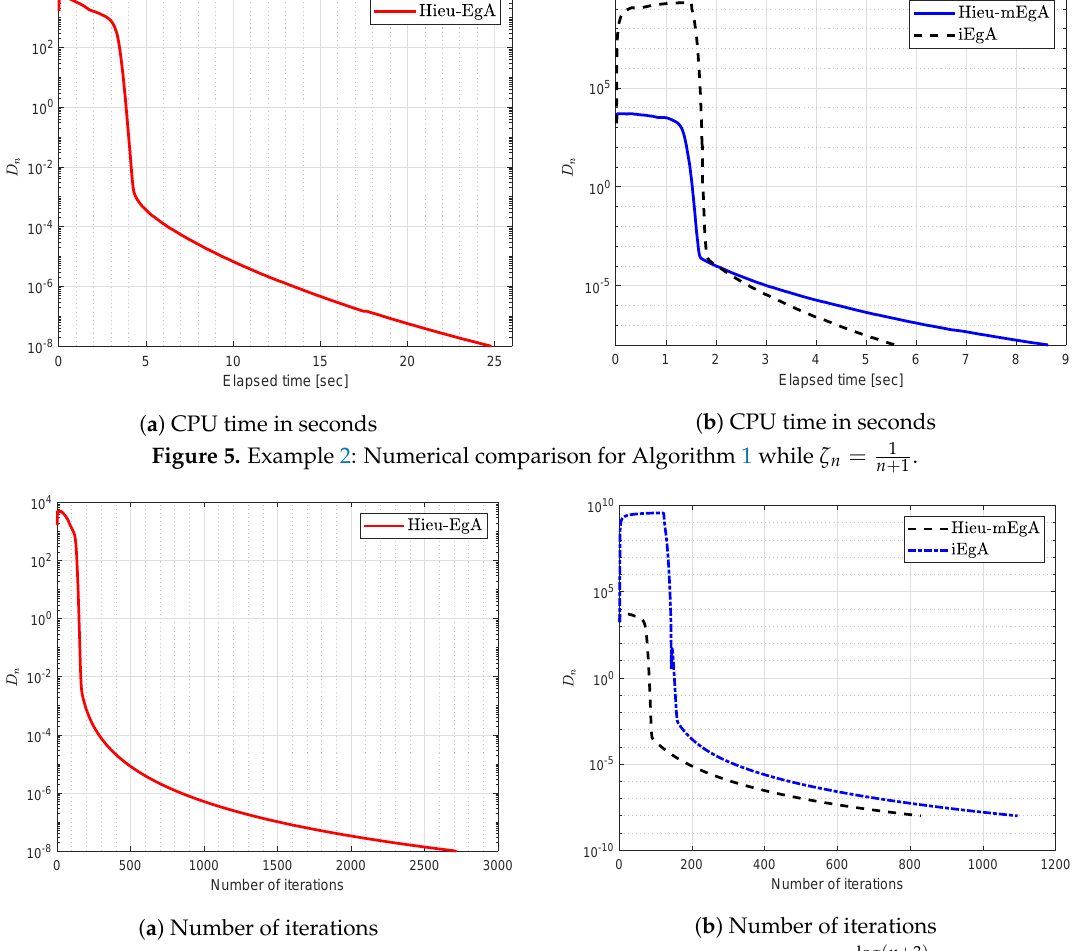
Figure 6. Example 2: Numerical comparison for Algorithm 1 while ζ n = log